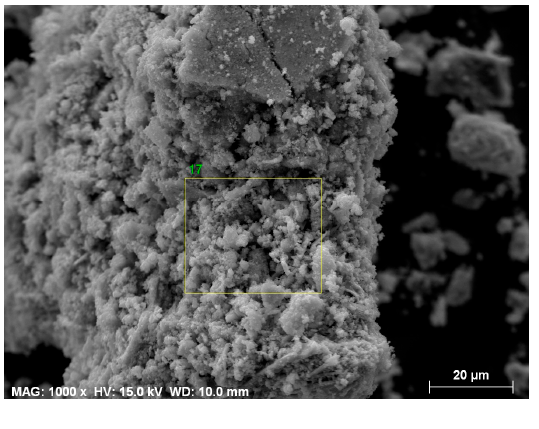
Figure 2. SEM image of the powder after auto-combustion ( a ) and color maps of the elements (Fe-red ( b ), Co-blue ( c ) and Sr-green ( d )).